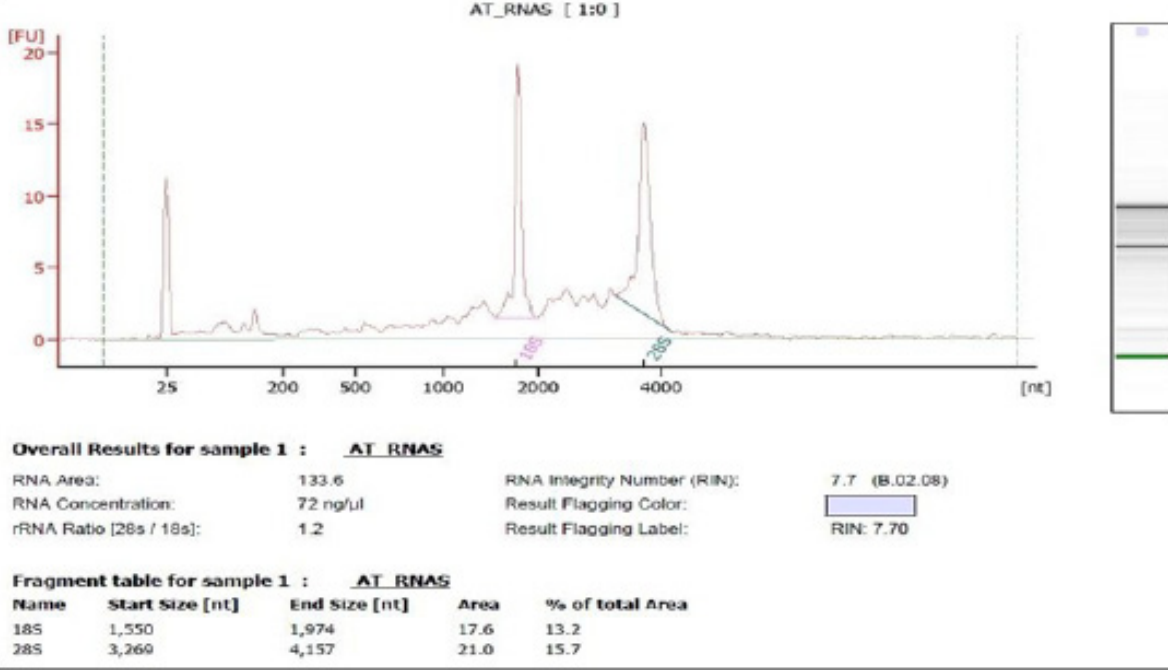
Figure 2. Agilent 2100 Bioanalyzer results of the p ooled RNA sample from ASD group (ASD).The two tall peaks at 2000 and 4000 are the ribosomal RNA . RNA integrity number ( RIN ) of the p ooled total RNA were calculated from the bioanalyzer traces. Pooled total RNA has RNA integrity number ( RIN ) 7.7.